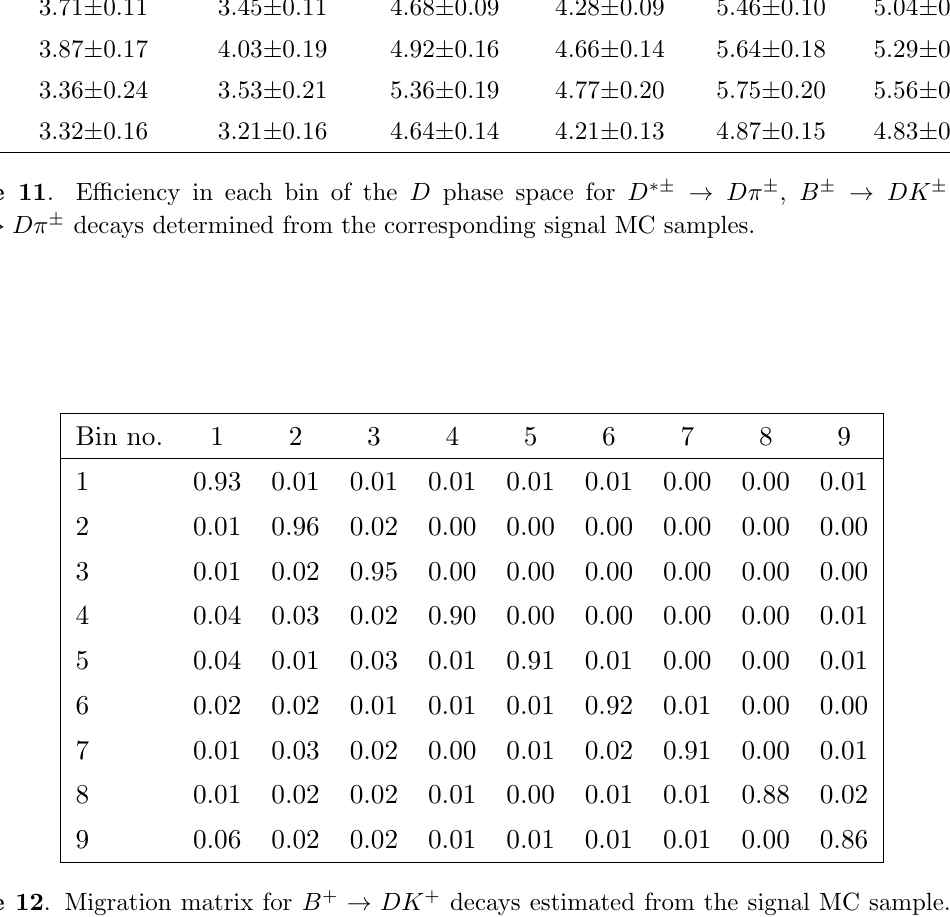
Table 12 . Migration matrix for B + ! DK + decays estimated from the signal MC sample. The rows correspond to the true bins and columns show the reconstructed